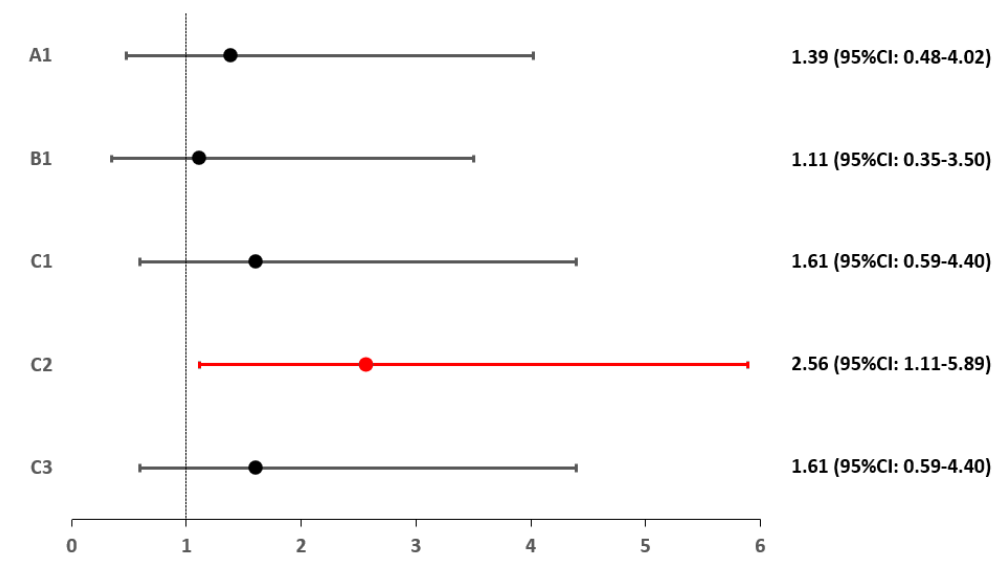
Figure 3. Relative risk of RLS occurrence in subgroups A1, B1, C1, C2 and C3.